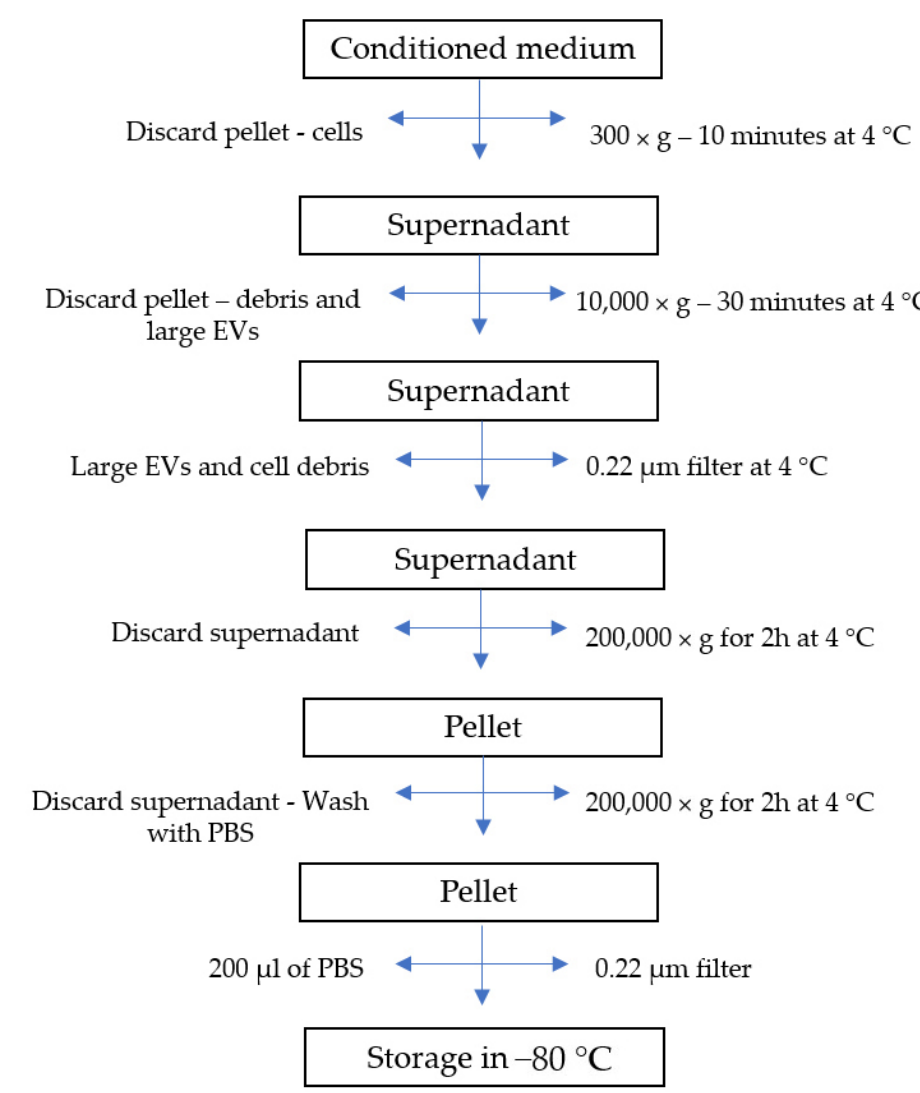
Figure 3. Flow diagram of extracellular vesicle isolation